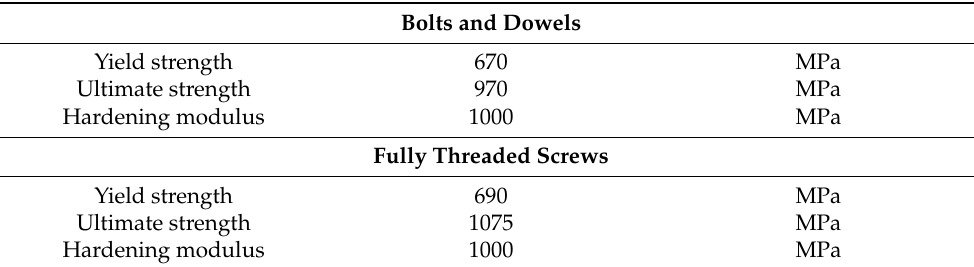
Table 5. Values for the plastic behavior of the material model for